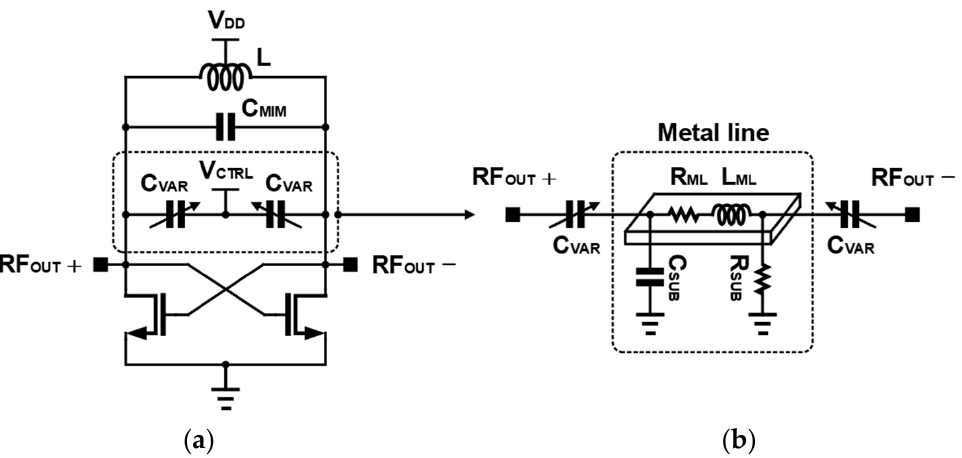
Figure 1. Typical cross-coupled VCO with LC tank: ( a ) schematic and ( b ) equivalent circuit of the parasitic components of the interconnection metal line.